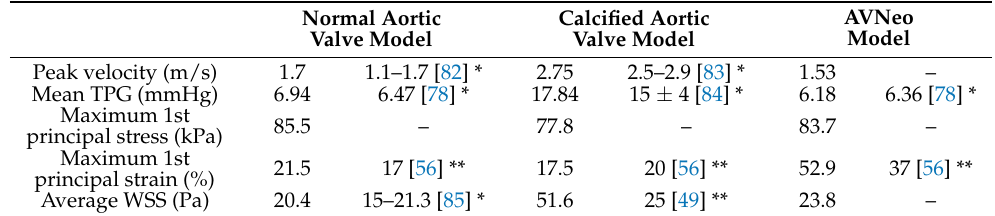
Table 2. The hemodynamic key indicators for normal, calcified, and AVNeo computational